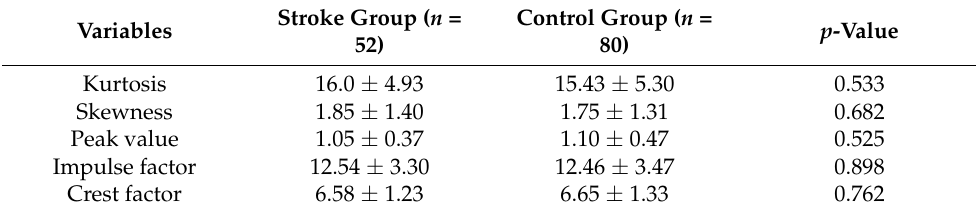
Table 3. Higher order statistical and impulsive metrics of the stroke and control